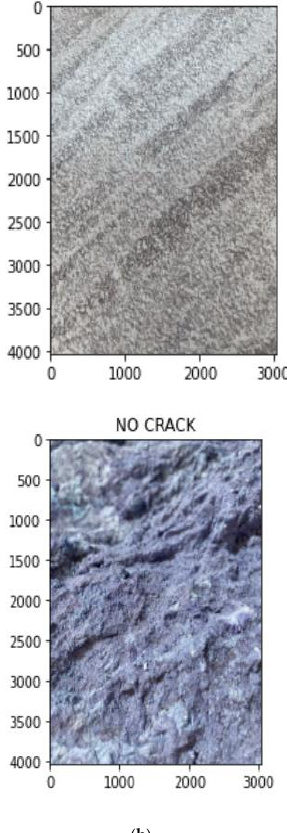
Figure 11. ( a , b ) Sample output images from the model classified as “No Crack” . Sensors 2023 , 23 , x FOR PEER REVIEW